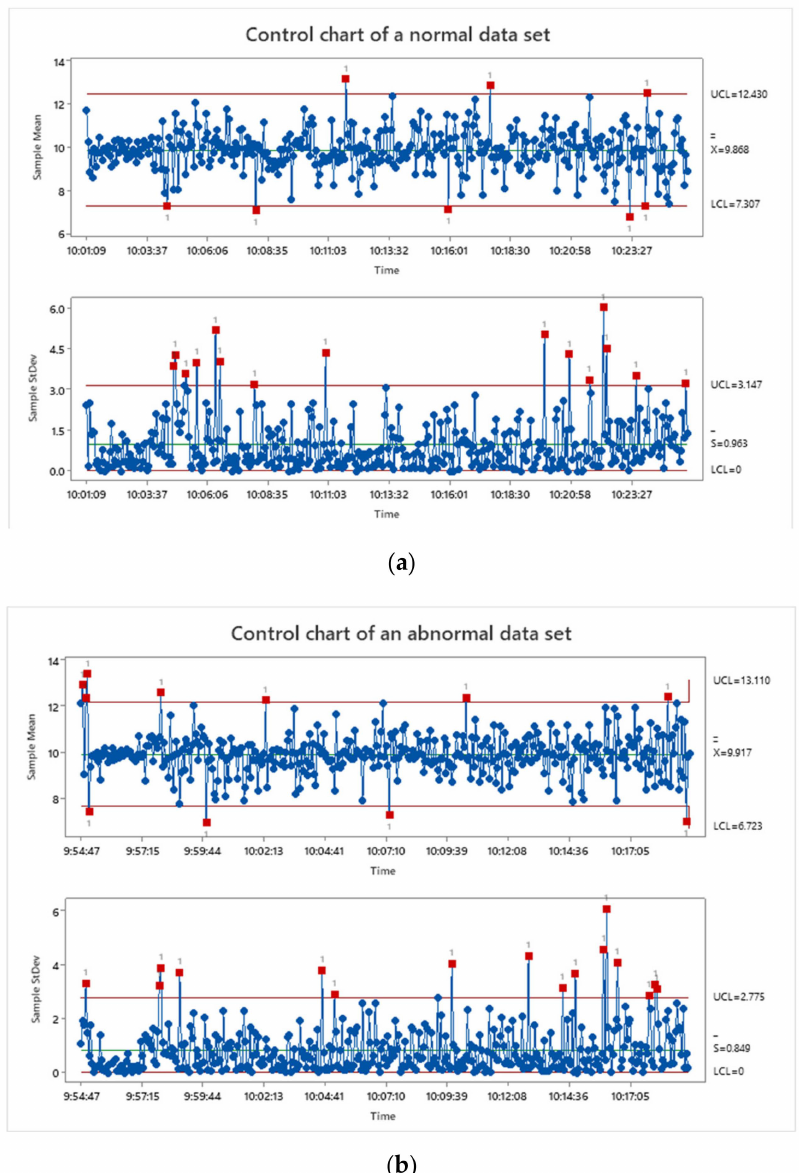
Figure 3. SPC control charts of two different data sets: ( a ) control Chart of a normal signal pattern, ( b ) control Chart of an abnormal signal